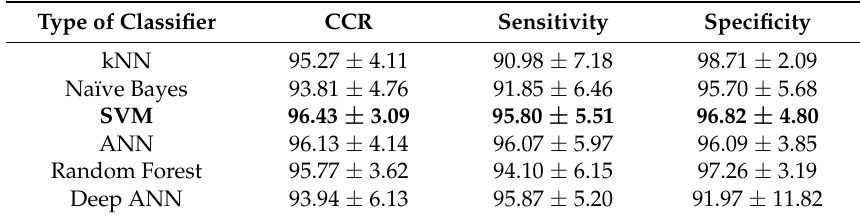
Table 2. The average value of Correct Classification Rate, Sensitivity and Specificity ± SD for different types of